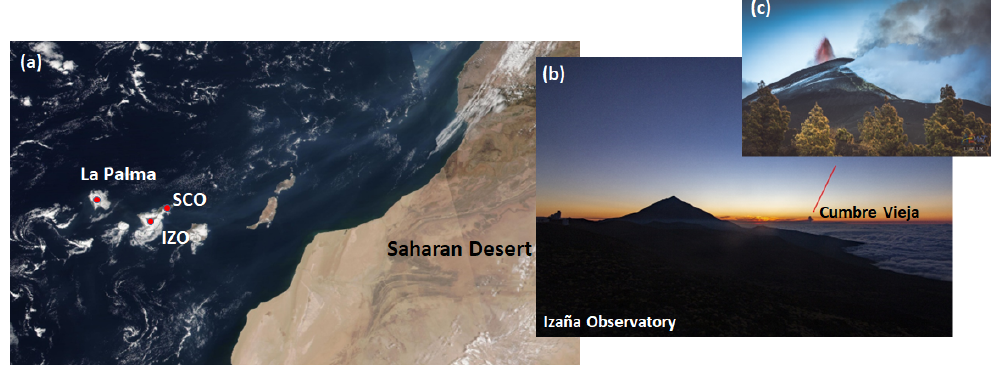
Figure 1. ( a ) Image captured by the Moderate Resolution Imaging Spectroradiometer (MODIS) sensor onboard the National Aeronautics and Space Administration (NASA)’s Terra satellite (https://worldview.earthdata.nasa.gov, accessed on 12 March 2022) on 24 September 2021, where the locations of the Izaña Observatory (IZO), Santa Cruz Observatory (SCO) and the volcano on La Palma are indicated with red dots. ( b ) Image of the volcano taken from Izaña Observatory. ( c ) Image of the volcano on La Palma